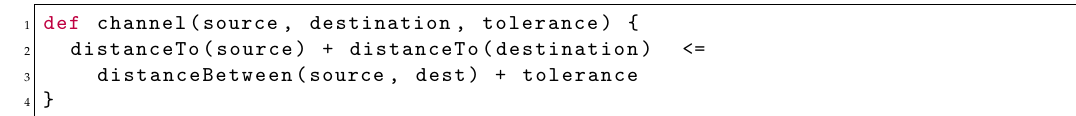
Figure 5. A self-healing channel in Protelis.